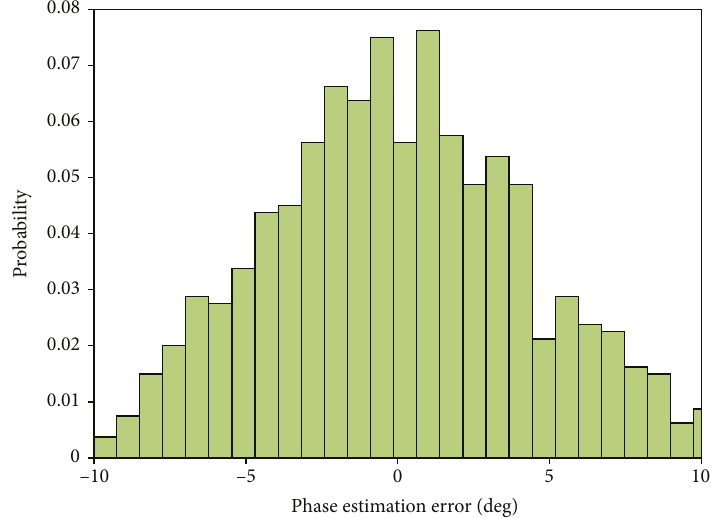
Figure 8: The phase calibration error histogram by 1000 Monte Carlo